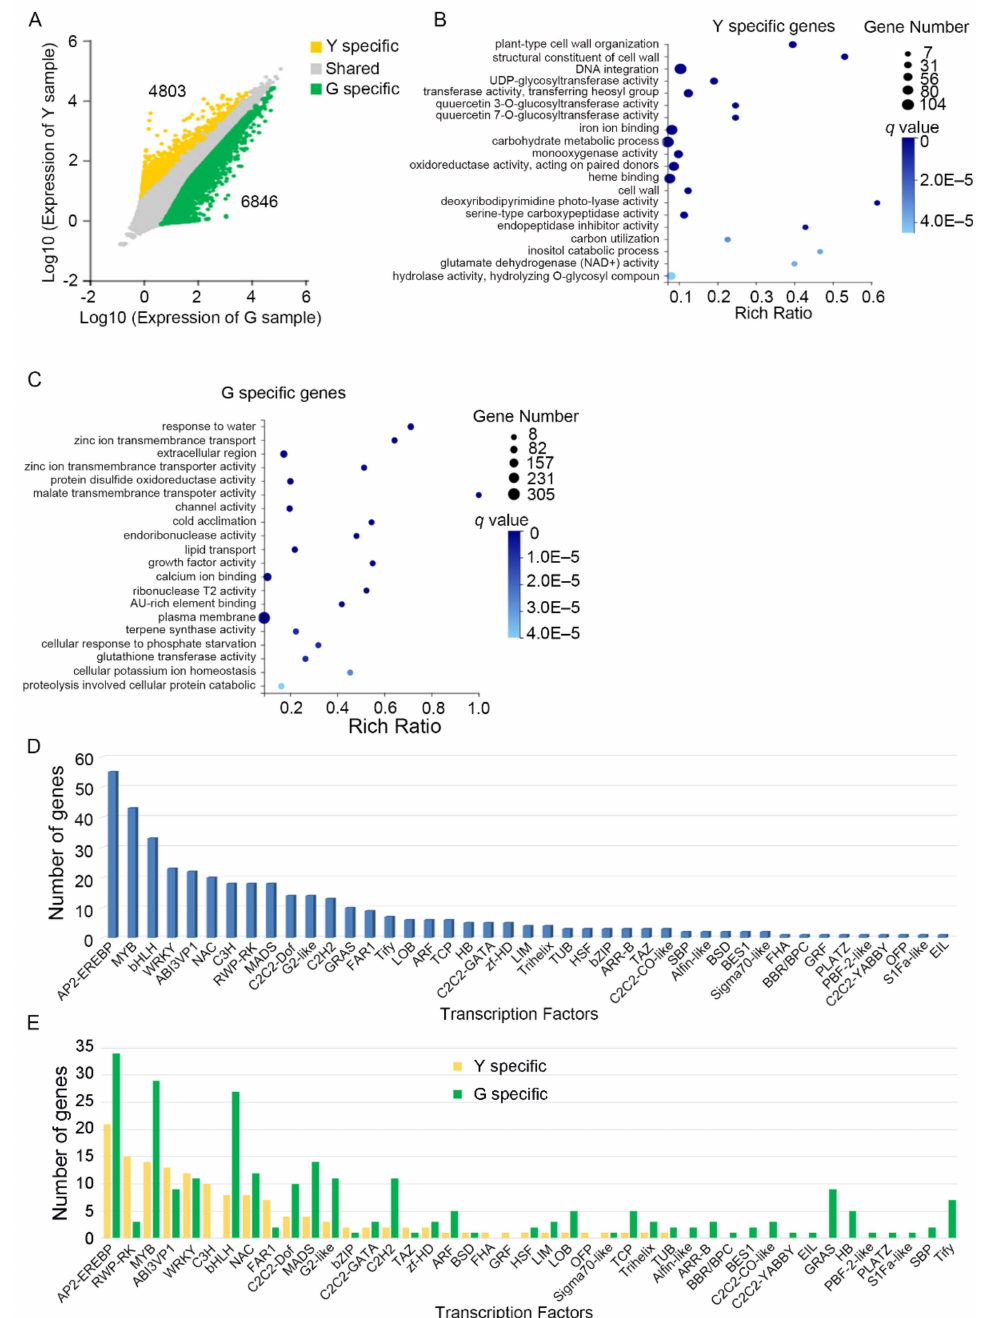
Figure 4. Unigenes that are differentially expressed between green and yellow leaf tissues. ( A ) Scatter plot showing the expression pattern of genes in green and yellow tissues. Yellow color indicates the upregulated unigenes in yellow tissues, green color indicates the upregulated unigenes in green tissues, gray color indicates genes that are expressed in both green and yellow tissues. The tissue- enriched unigenes were identified by q ≤ 0.05, with |Log2(RPKM_Y/RPKM_G)| ≥ 1; ( B – C ) gene ontology (GO) analysis of differentially expressed unigenes in yellow tissues ( B ) or green tissues ( C ). G indicates green leaf tissue; Y indicates yellow leaf tissue; ( D – E ) number of tissue-enriched unigenes from different transcription factor family; ( D ) all unigenes that are differentially expressed in both green and yellow tissues were analyzed; ( E ) the unigenes that are differentially expressed in green and yellow tissues were